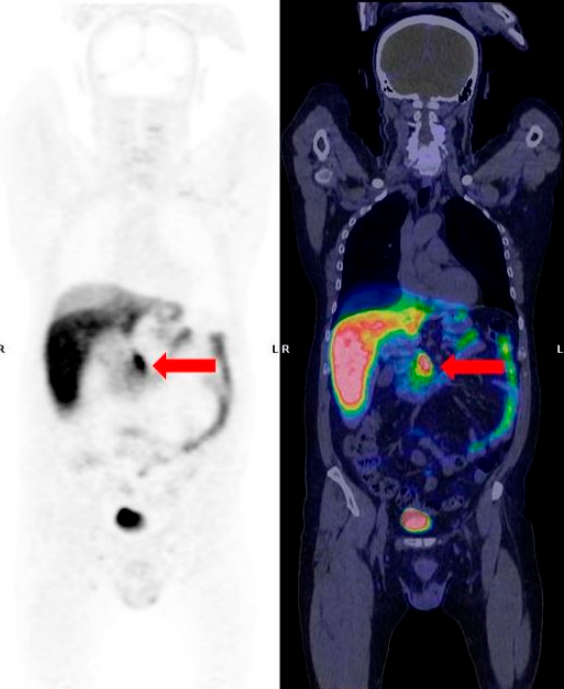
Figure 1. 68 Ga-DOTA-TOC PET/CT coronal images. The red arrows show a very common finding: a physiological diffuse uptake in the pancreatic head/uncinate process.